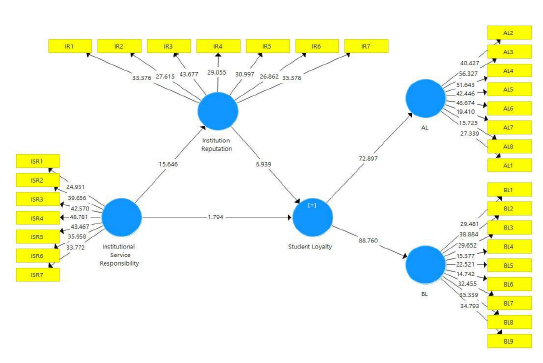
Fig. 3. Structural